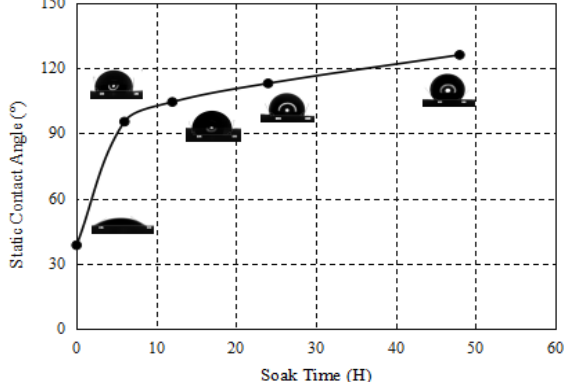
Figure 16. Curve between soaking time of rock in chemical agent and contact angle [27].